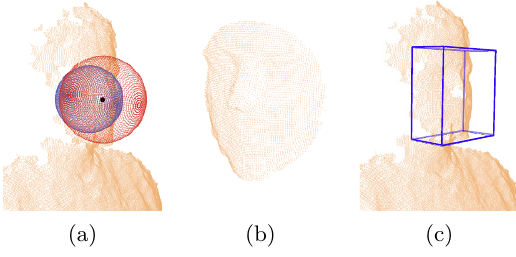
Fig. 3 Head detection: (a) fixing the head center and generating the red sphere, (b) head point cloud, and (c) bounding box of the head point cloud.